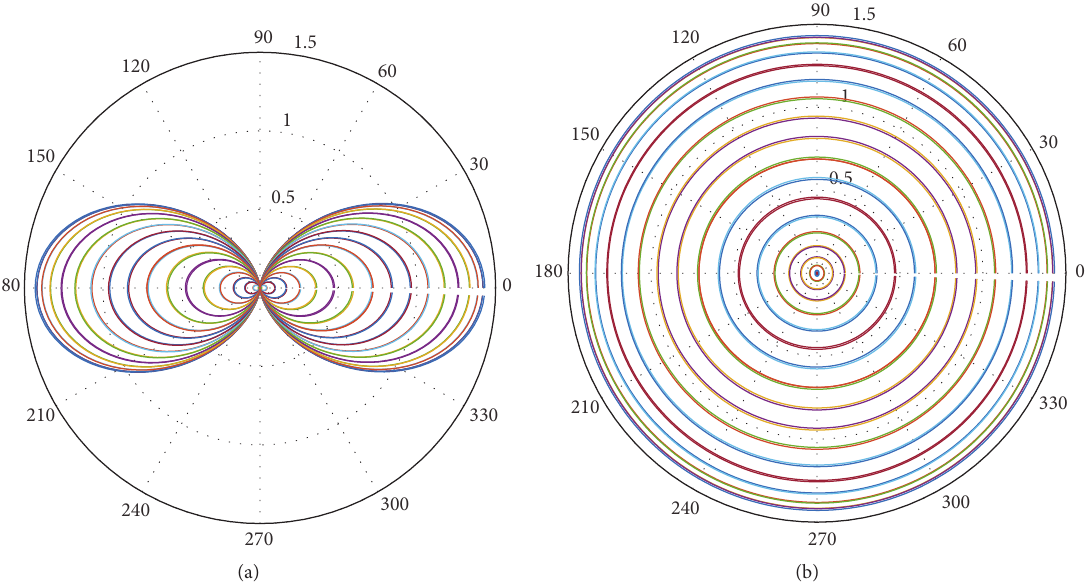
Figure 6: Simulated components (a) 𝐺 𝜃 (𝜃) and (b) 𝐺 0 (𝜃) of the antenna gain at 462 MHz for different values of 0 from 0 ∘ to 180 ∘